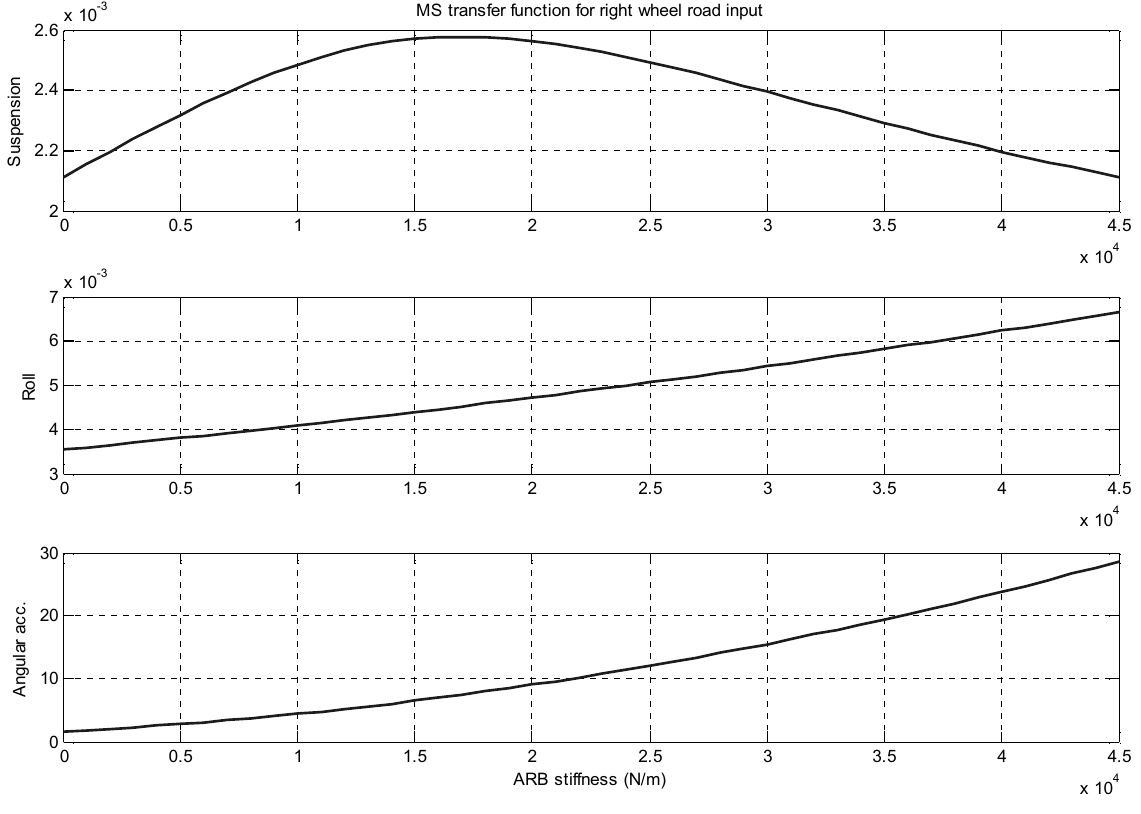
Fig. 2. RMS values of transfer function for right road